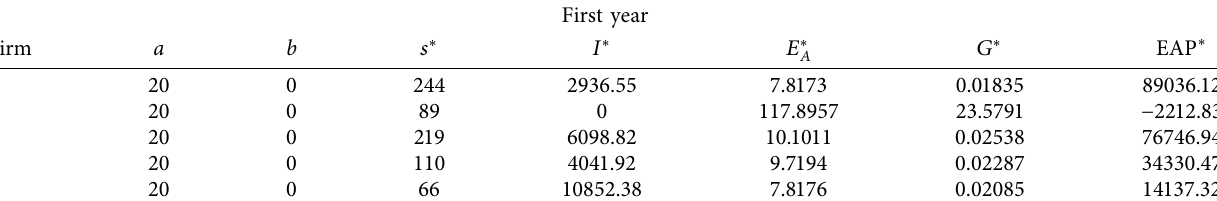
Table 4: Optimum solutions for the first year.